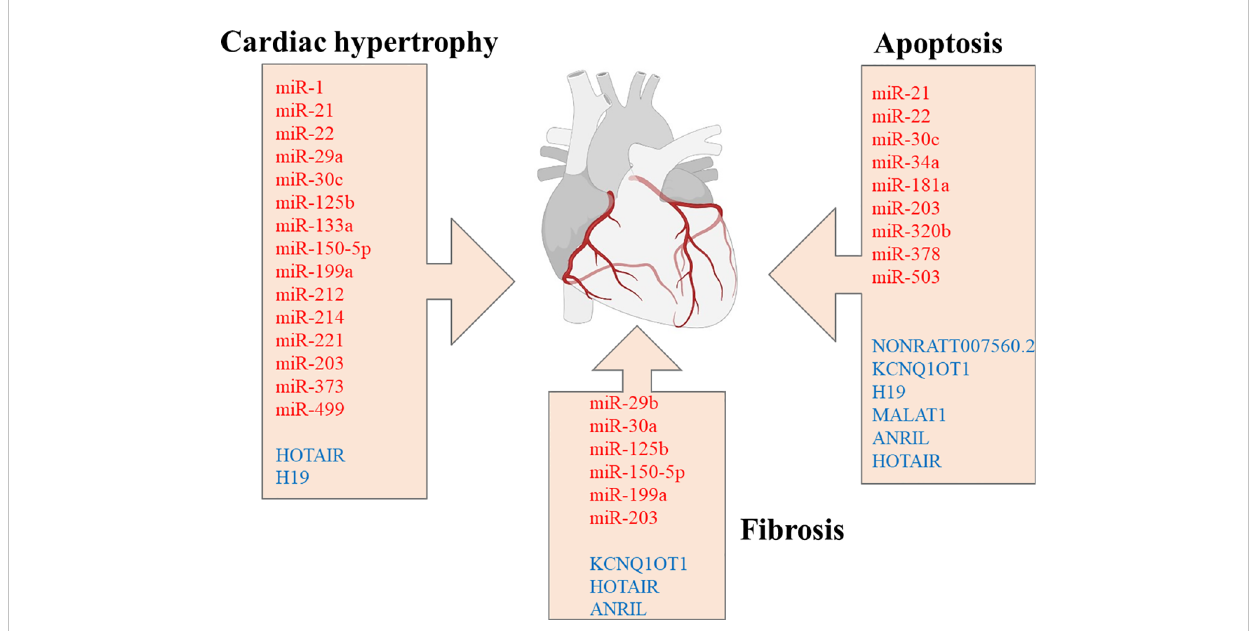
FIGURE 1 miRNAs and lncRNAs are implicated in regulating cardiac hypertrophy, apoptosis, and fi brosis. miRNAs are marked in red, whereas lncRNAs are marked in blue color. miRNAs, microRNAs; lncRNA, long non-coding RNAs. Created with